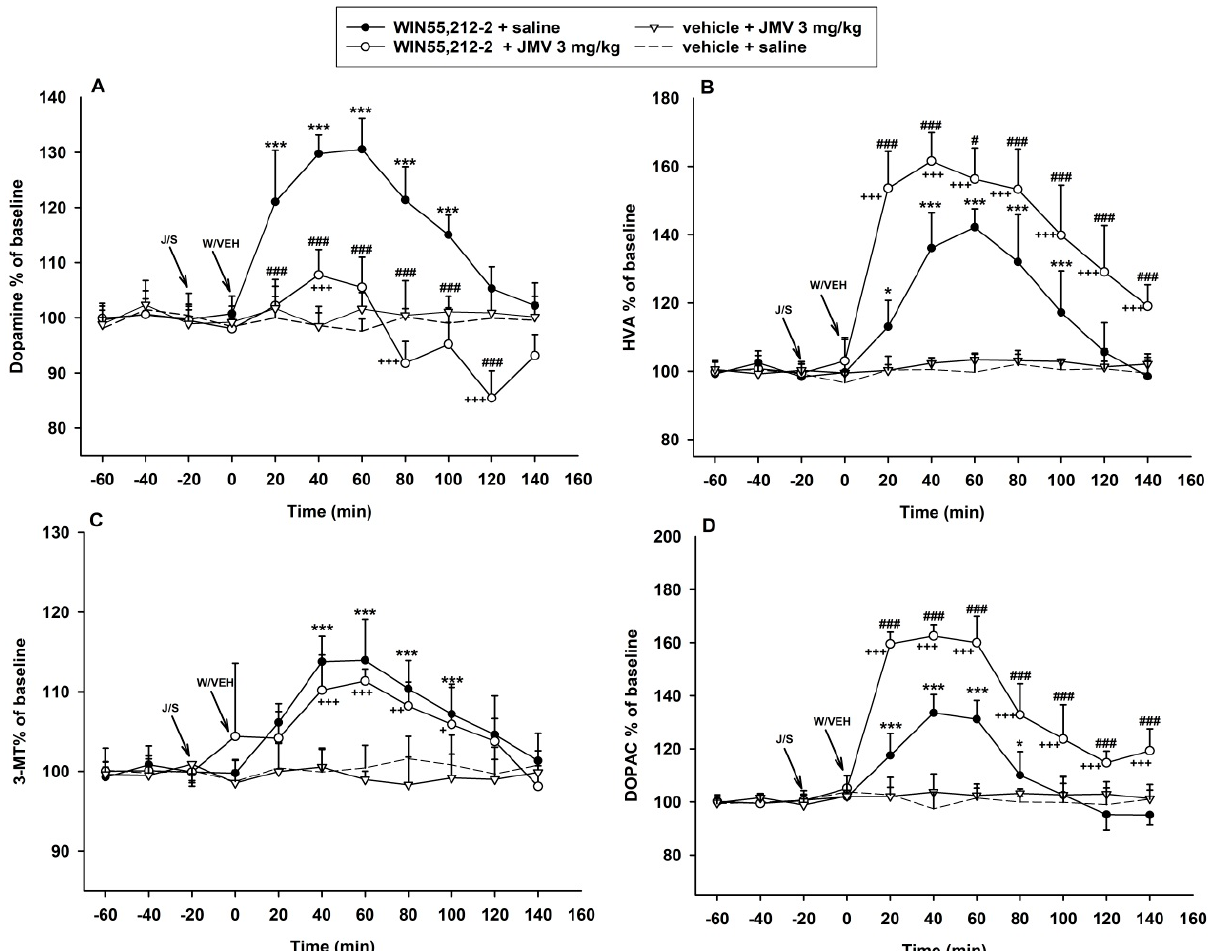
Figure 2. Effects of growth hormone secretagogoue receptors (GHS-R1A) antagonist (JMV2959) on WIN55,212-2-induced dopamine and its metabolites’ extracellular changes in the rat nucleus accumbens shell (NACSh). JMV2959 3 mg/kg was given i.p. 20 min before 2.4 mM/0.5 µ L WIN55,212-2 or vehicle 0.5 µ L was administered into the posterior ventral tegmental area (VTA) injection ( n = 6; means ± SEM). Changes in accumbens dopamine are illustrated in graph ( A ), changes in homovanillic acid (HVA), 3-methoxytyramine (3-MT) and 3,4-dihydroxyphenylacetic acid (DOPAC) are illustrated in the graphs ( B – D ), respectively. The effects are illustrated as follows: saline + WIN55,212-2 (filled circle; n = 7), 3 mg/kg JMV2959 + WIN55,212-2 (open circle; n = 6), 3 mg/kg JMV2959 + vehicle (open triangle; n = 4), saline + vehicle (dotting; n = 7). Differences between saline + WIN55,212-2 and saline + vehicle groups are expressed as *** p < 0.001, * p < 0.05. Differences JMV2959 + WIN55,212-2 and saline + vehicle groups are expressed as +++ p < 0.001, ++ p < 0.01, + p < 0.05. Differences between groups saline + WIN55,212-2 and 3 mg/kg JMV2959 + WIN55,212-2 are expressed as ### p < 0.001, # p < 0.05.